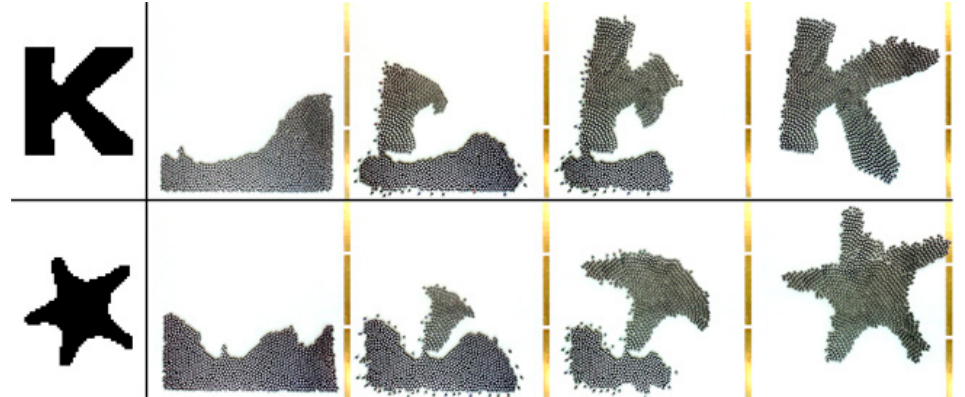
Figure 8. A swarm of 1024 Kilobots gradually arrange themselves into a ‘K’ shape and a star shape [31] .